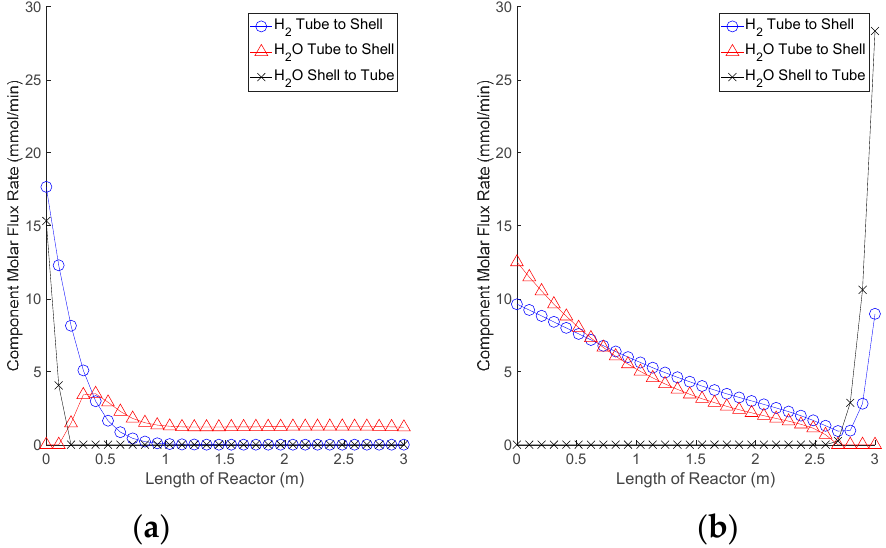
Figure 10. ( a ) Flux profile with the highest H 2 recovery. ( b ) Flux profile with the highest CO 2 capture. The profiles in Figure 10 explain how the high CO 2 capture or high H 2 recovery is achieved. In Figure 10a, the process reaches an equilibrium within the first third of the reactor due to a relatively high flowrate of sweep gas. Slightly manipulating the sweep gas flowrate at this condition would reduce the permeation, but the membrane reactor would still reach this equilibrium. This results in very good H 2 recovery, but poor CO 2 capture as CO 2 continues to permeate out of the tube side despite the H 2 recovery process already being finished. Conversely, Figure 10b shows that steam injection is occurring at the end of the membrane reactor, leaving little room left in the reactor for the sweep gas to capture the newly produced H 2 product. This low sweep gas flowrate means that very little CO 2 will escape from the reactor, leading to optimum CO 2 capture, but at the cost of reducing H 2 recovery. The operating points selected for the simulations in Figure 10 show what is happening at the extreme ends of the Pareto frontier. For the next simulation, the best compromise point is selected from the elbow of the Pareto front to see how the polymer membrane reactor can achieve both high H 2 recovery and CO 2 capture. The results of this simulation are shown in Figure 11.